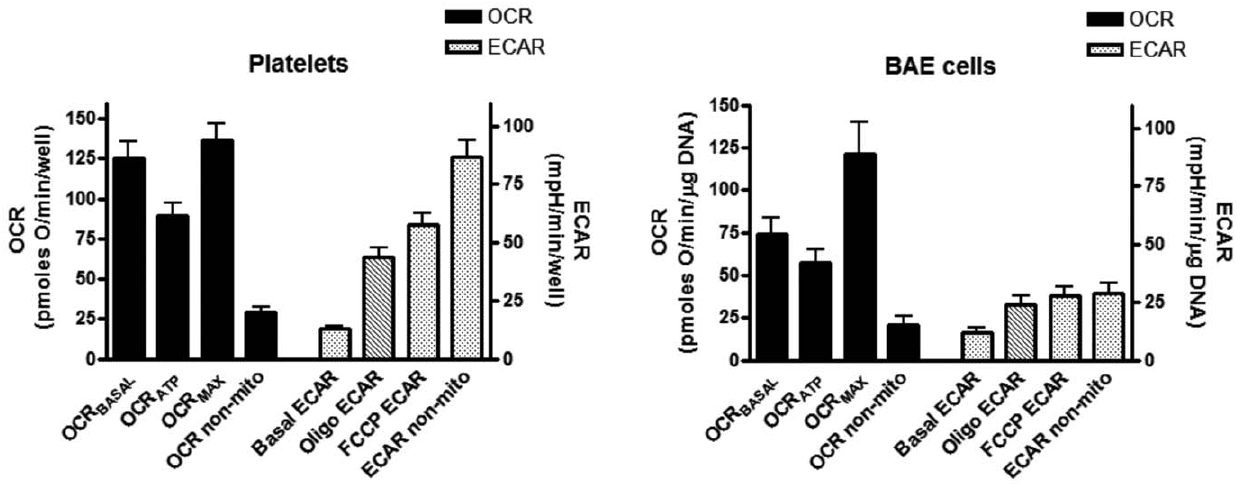
Figure 7. Comparison of mitochondrial bioenergetics between intact freshly isolated human platelets and BAE cells grown at 5.5 mM glucose. Glucose concentration was maintained at 5.5 mM during extracellular flux experiments. Platelet data represent mean 6 SEM values for all 15 subjects that comprised the data in figure 6. BAE cell data represents 14 repetitions (mean 6 SEM) for each data point.